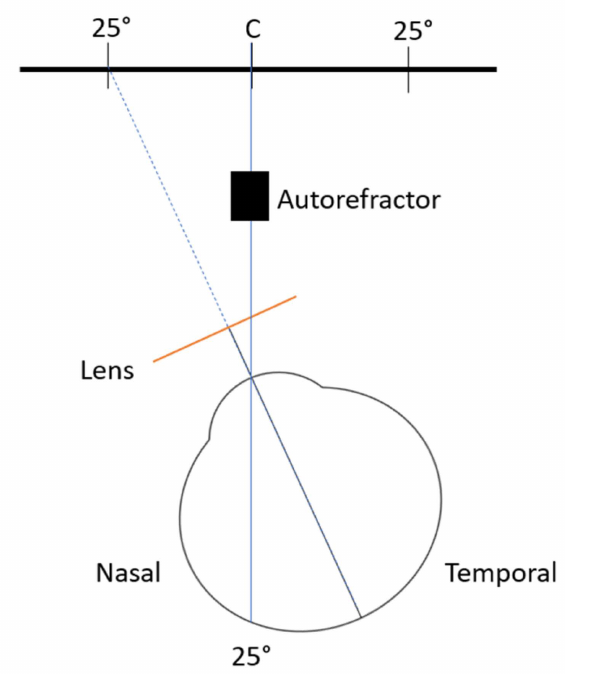
Figure 2. Schematic illustration of the measurement of the peripheral refraction at 25 ◦ temporal retina of the right eye. Not to